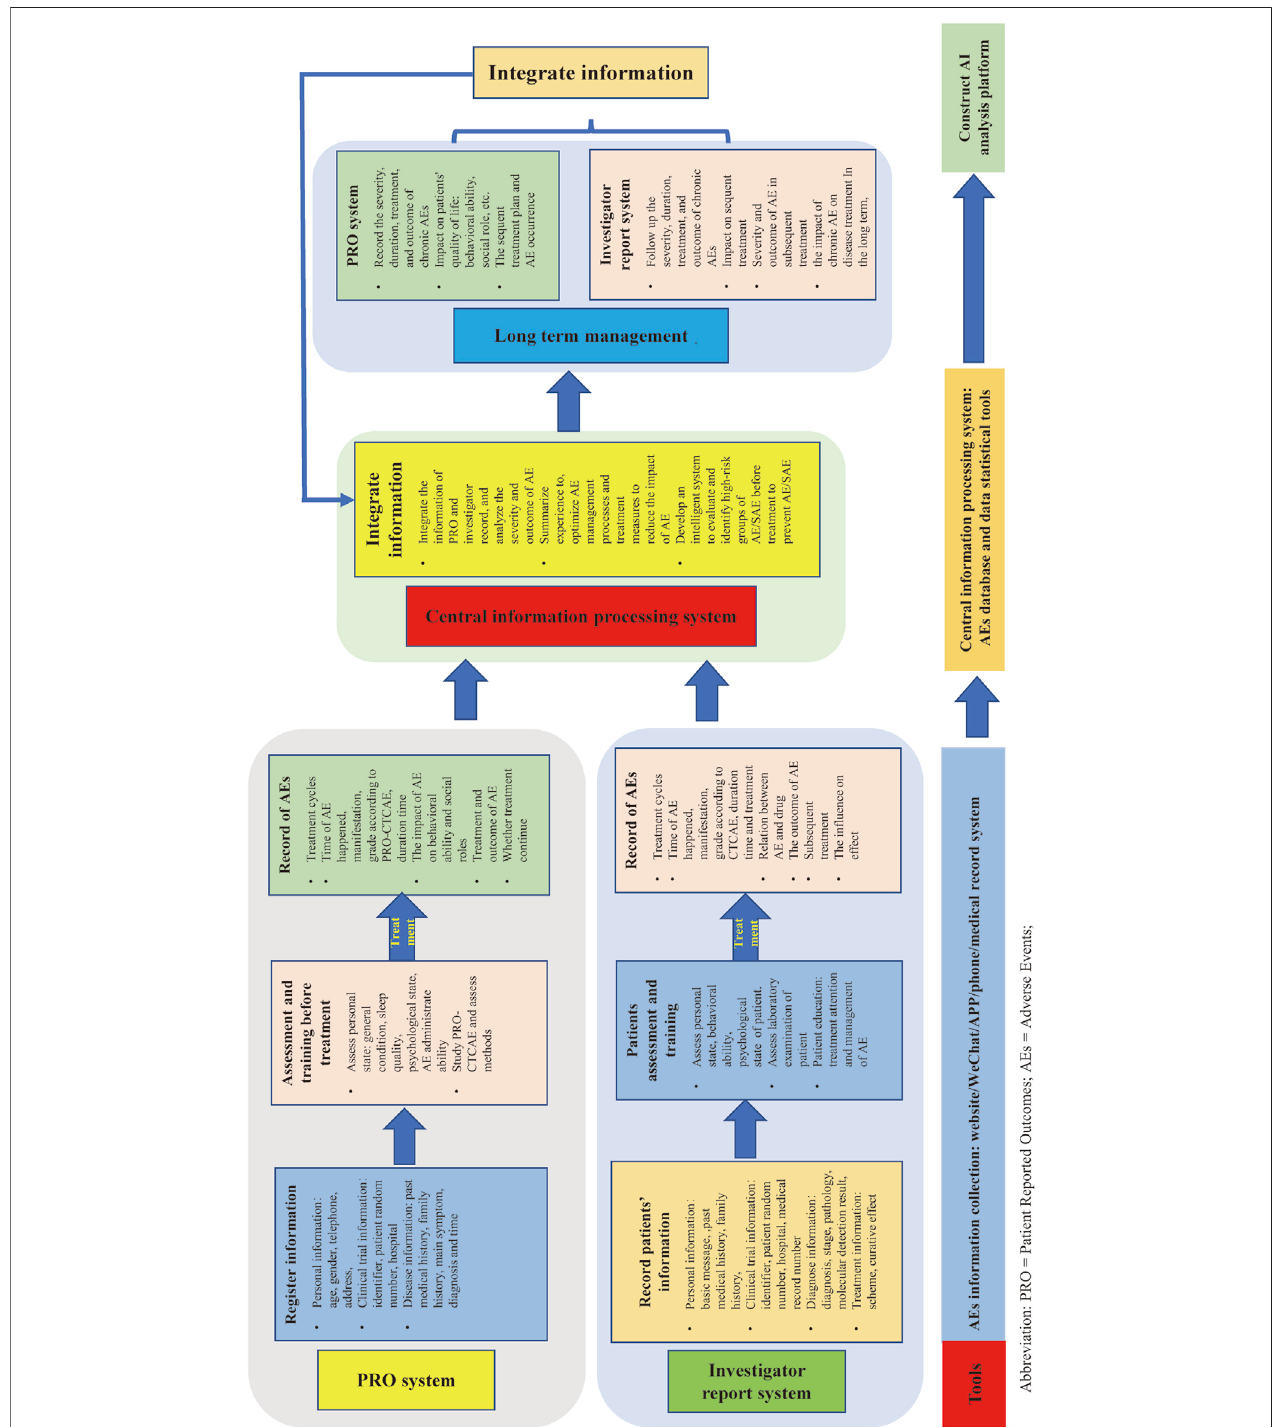
FIGURE 6 | PRO and investigator system AEs comprehensive reporting